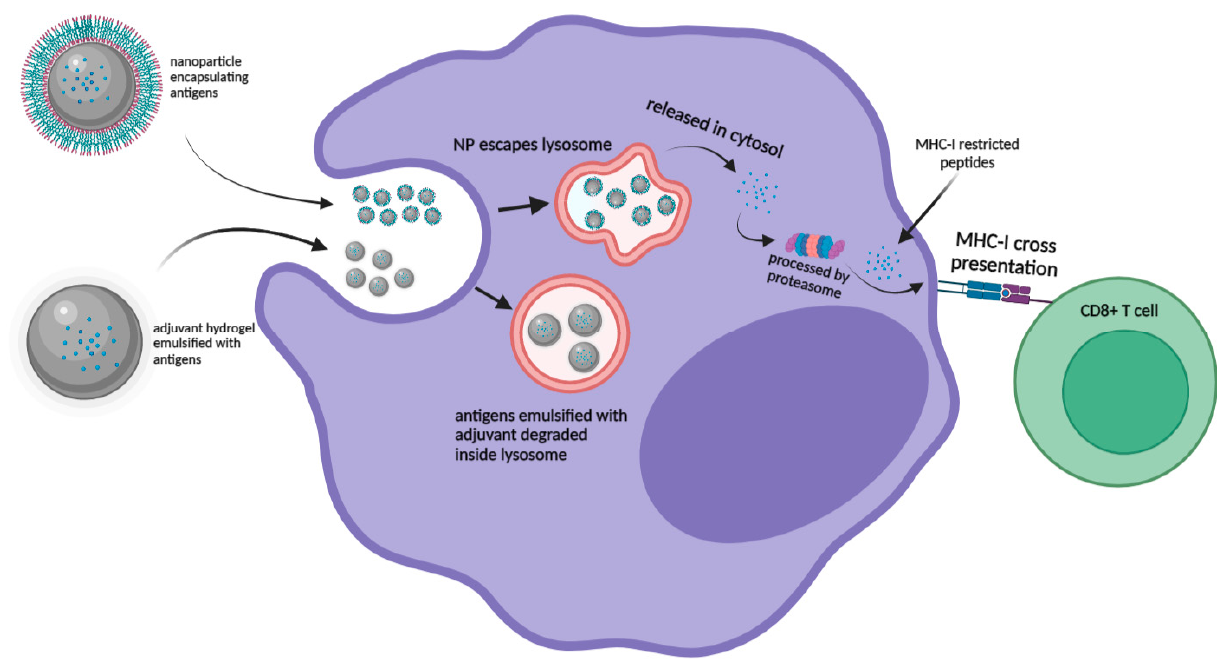
Figure 3. Graphic representation of nanoparticle encapsulated antigens escaping lysosome and processed through “cytosolic” pathway for MHC-I presentation for CD8 + T cells in comparison with adjuvant emulsified antigens degrading within the